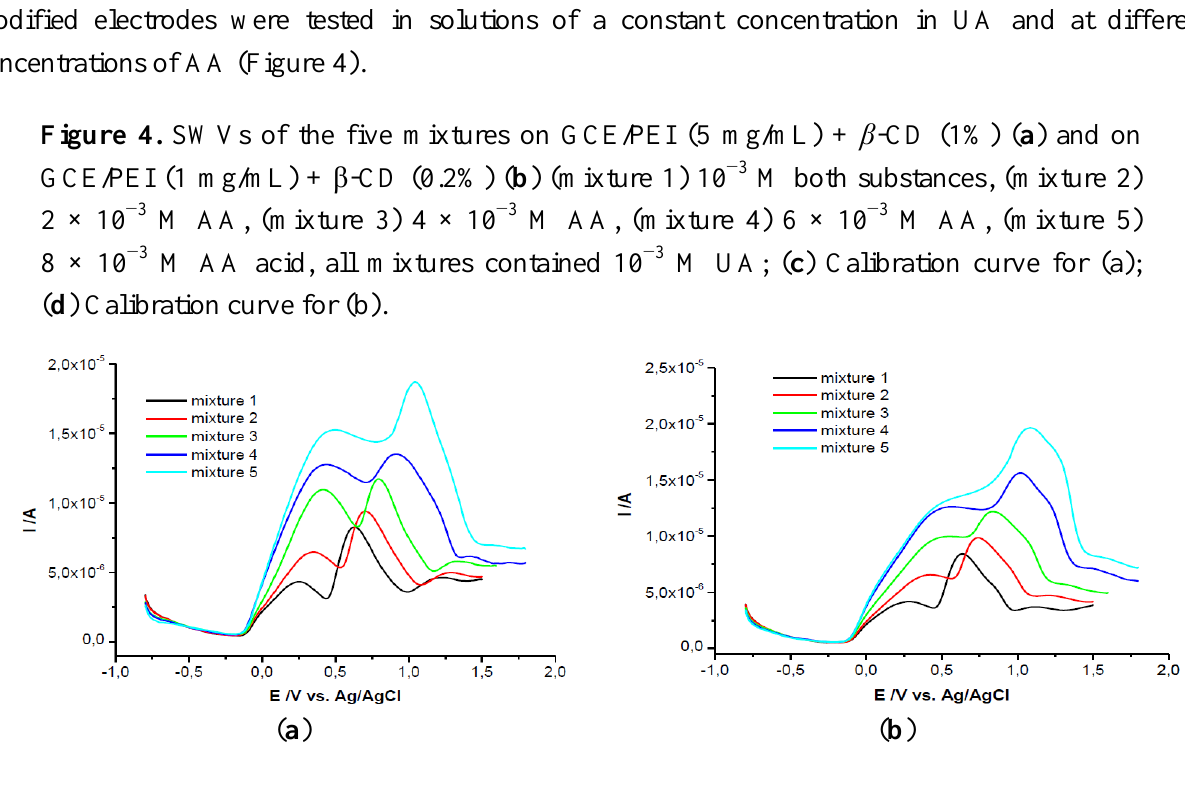
Figure 4. SWVs of the five mixtures on GCE/PEI (5 mg/mL) + β -CD (1%) ( a ) and